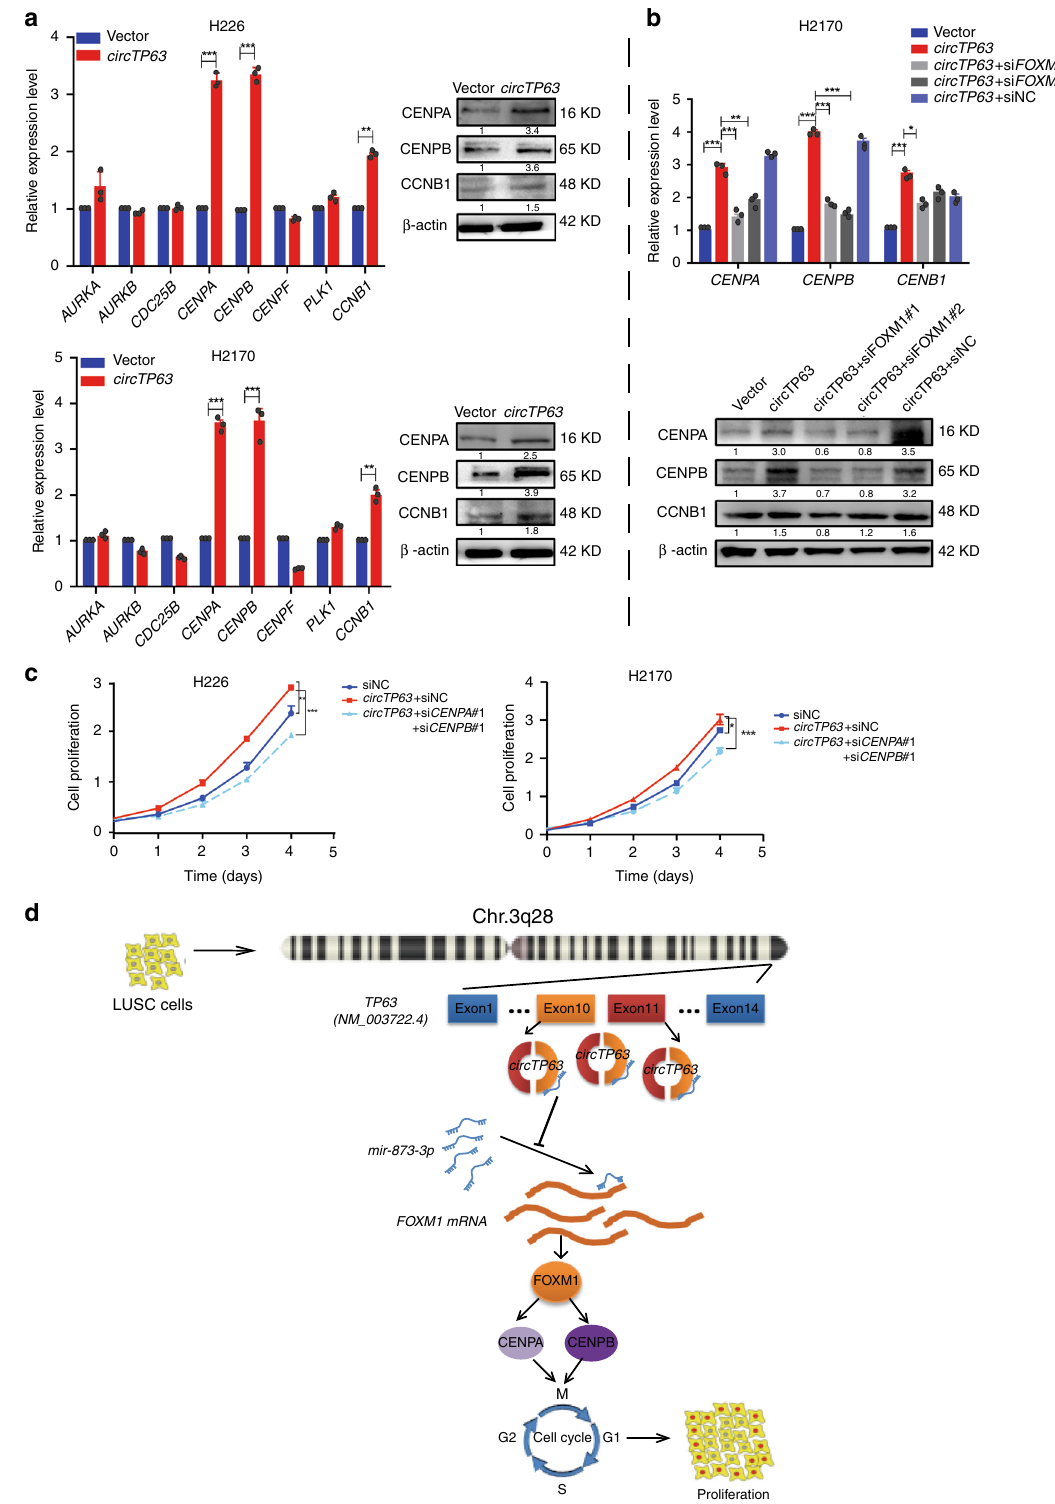
Fig. 6 CENPA and CENPB are regulated by cicrTP63 through FOXM1. a The mRNA and protein levels of cell cycle-related genes in H226 and H2170 cells with circTP63 overexpression. b Expression changes of CENPA , CENPB , and CCNB1 after knockdown of FOXM1 in H2170 cells with circTP63 overexpression. c Cell proliferation assay for H226 and H2170 cells with circTP63 overexpression and joint knockdown of CENPA and CENPB . d Hypothesis diagram illustrates function and mechanism of circTP63 in LUSC progress. The error bars a – c represent s.d. ( n = 3). * p < 0.05; ** p < 0.01; *** p < 0.001, two-tailed t -test. Source data are provided as a Source Data fi le